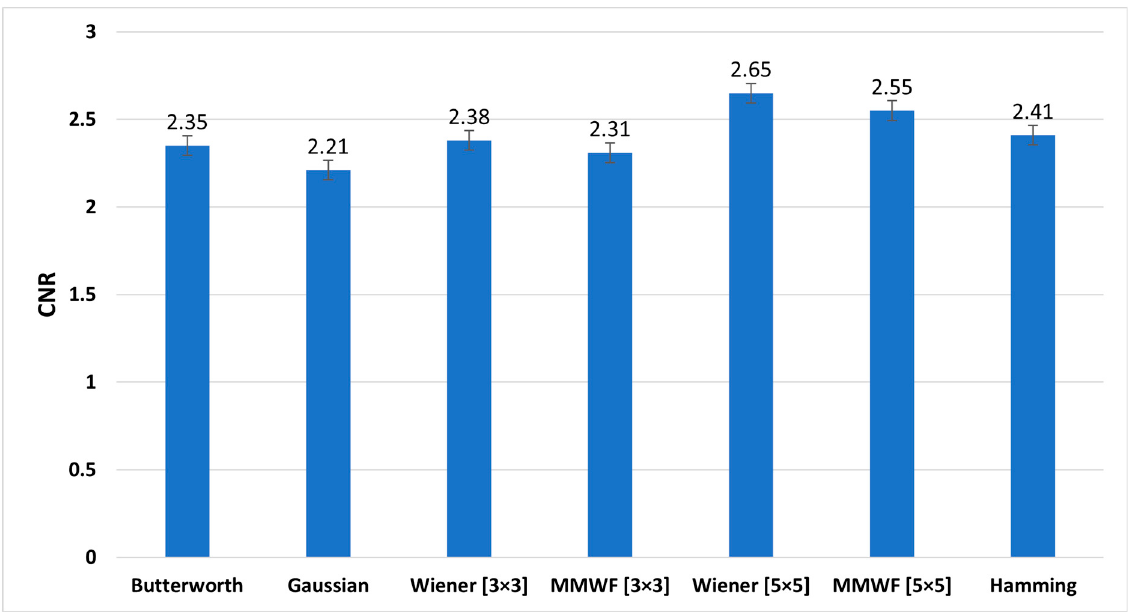
Figure 10. Comparison of average contrast-to-noise (CNR) graph of different filters for studied myocardial perfusion SPECT images. Table 3. Average ( ± standard deviation (SD)) indices of signal-to-noise (SNR), peak signal-to-noise (PSNR), and contrast-to-noise (CNR) of different filters for the studied myocardial perfusion SPECT images.